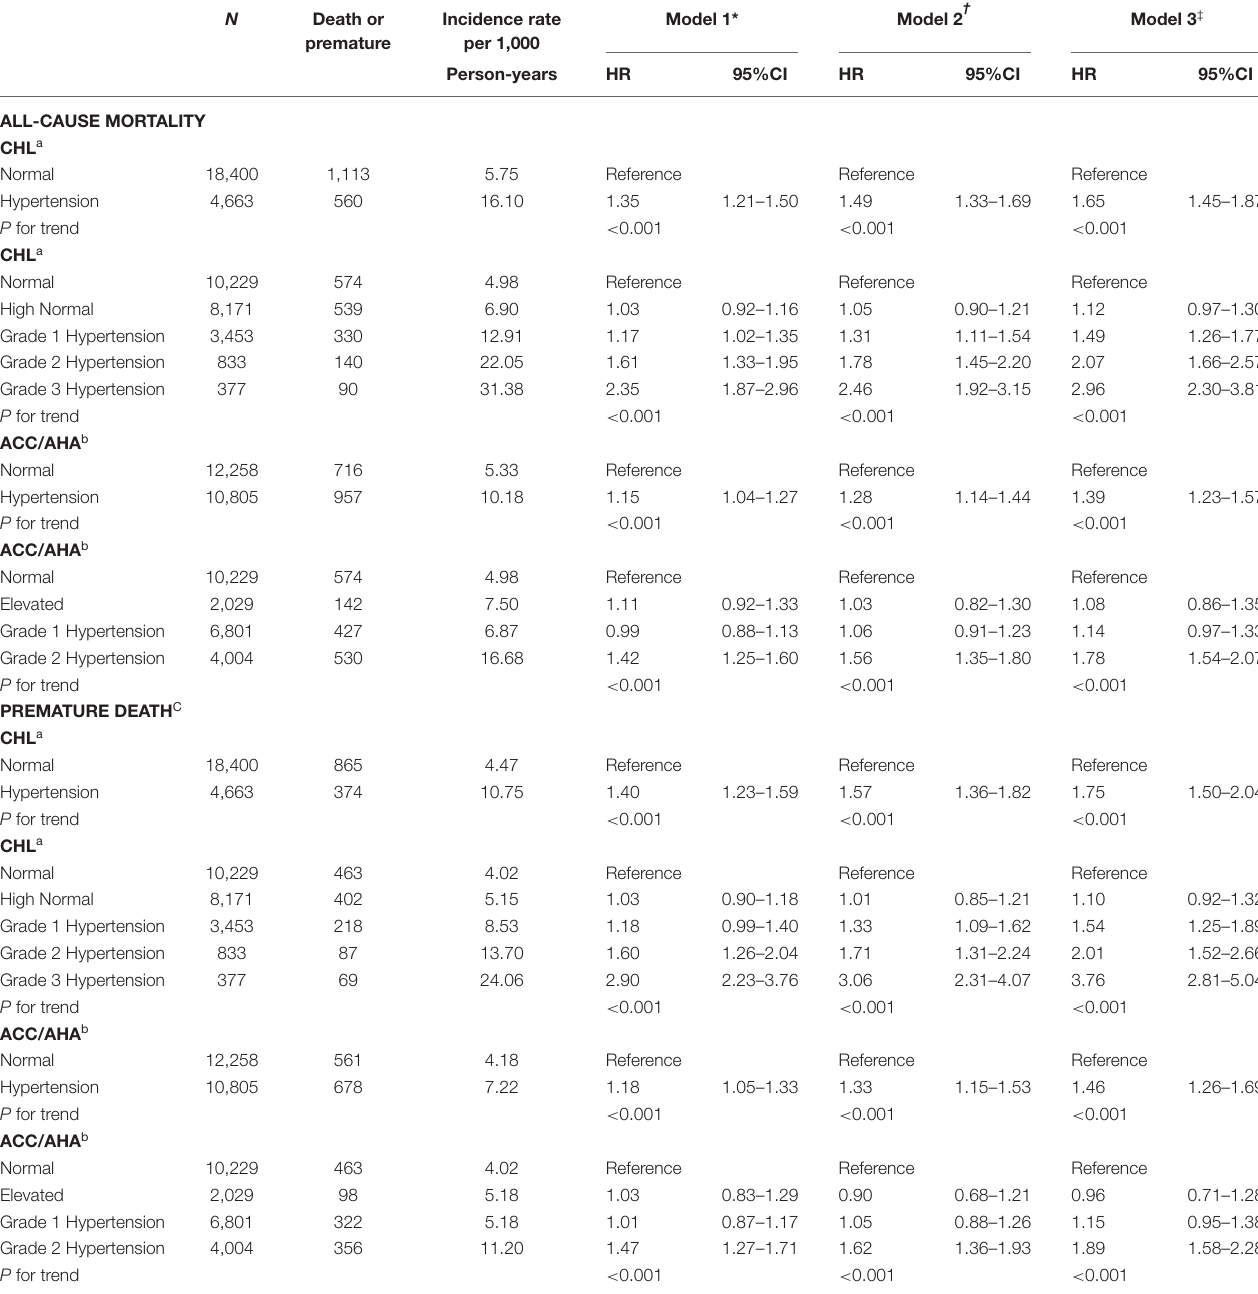
TABLE 1 | Hazard ratios of all-cause mortality and premature mortality according to hypertension categories by Chinese Hypertension League (CHL) and European Society of Cardiology (ESC)/European Society of Hypertension (ESH) and American College of Cardiology (ACC)/American Heart Association (AHA) definitions a,b